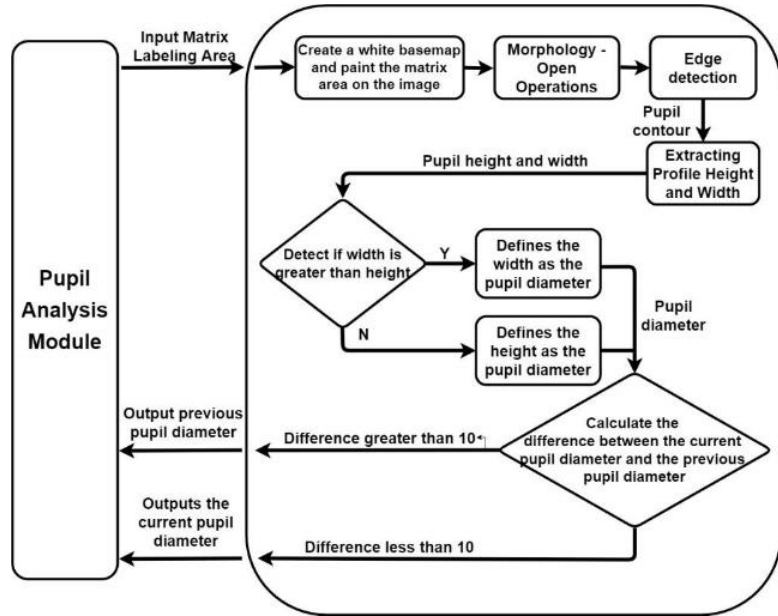
Figure 26. Architecture of the developed CCLPF-based pupil analysis module.